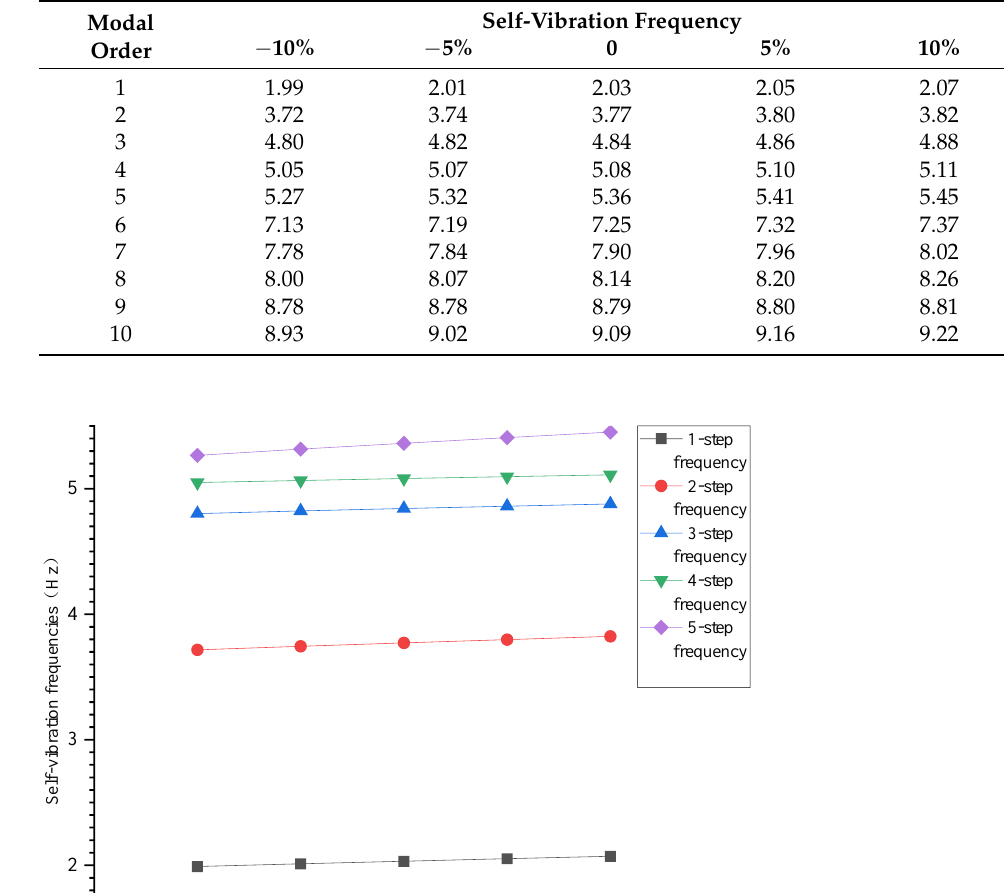
4.446 Figure 14. First-order vertical vibration diagram of rigid connection /m.